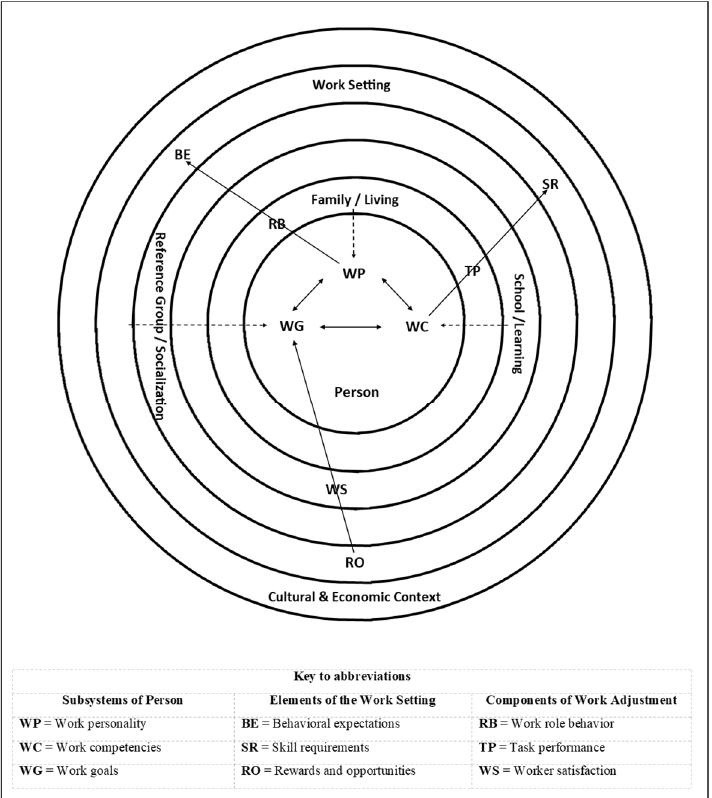
Figure 1. Hershenson’s Work Adjustment Model (Source: Hershenson 1996, p. 444).